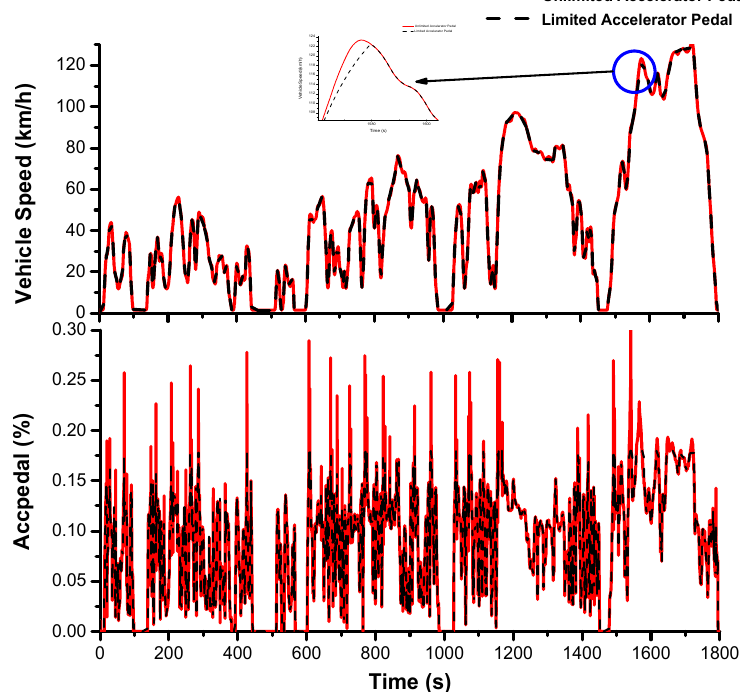
Figure 9. Comparison of speed profile and accelerator pedal depth in changing driving style.